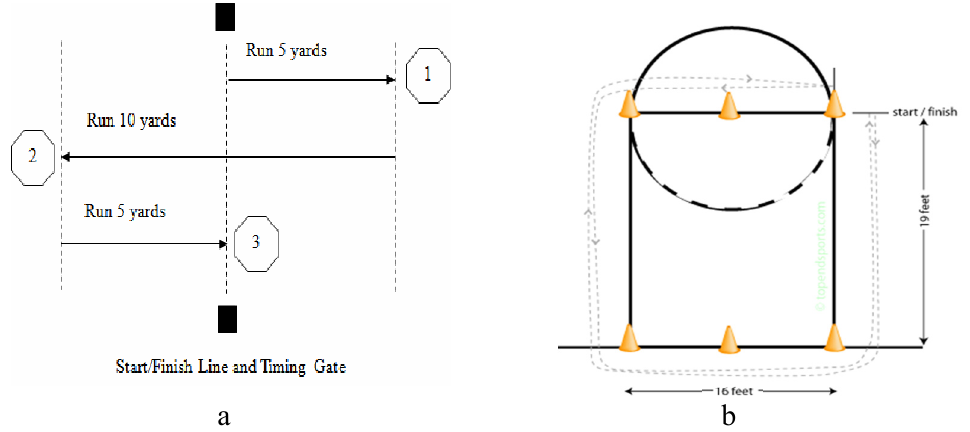
Figure 1. Lane Agility Drill ( a ) and Reactive Shuttle Run test description ( b ).